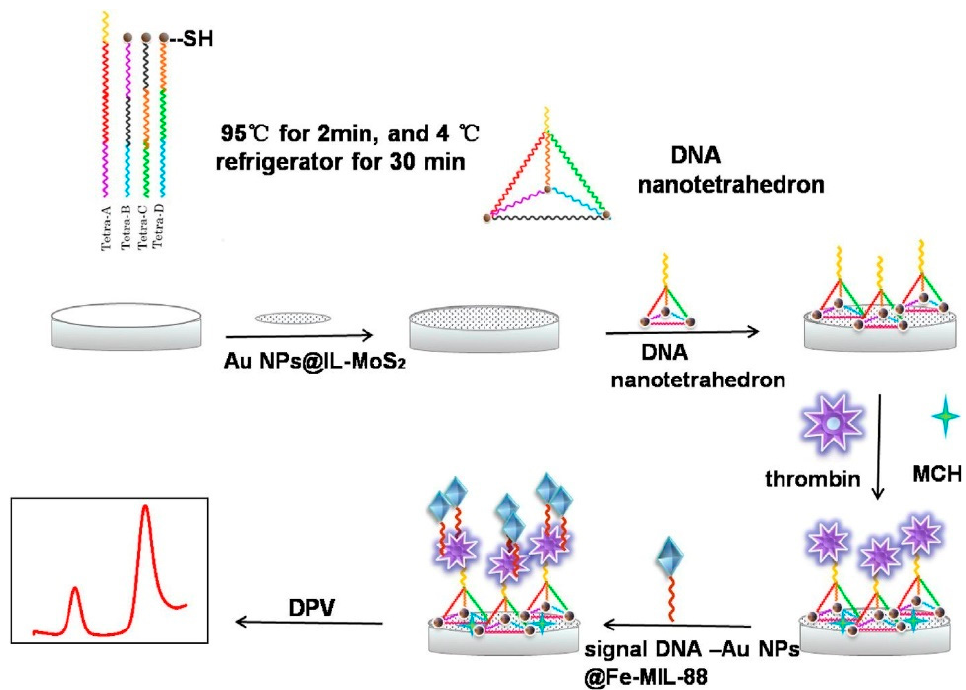
Figure 3. Electrochemical aptasensor for thrombin detection in blood serum. A glassy carbon elec- trode is coated with a AuNPs-IL-MoS 2 composite and functionalized with SH-DNA nonotetrahedrons that bind thrombin molecules and serve as supports for successive binding of AuNPs-Fe-MIL-88 MOFs. Image adapted from [28] with permission of Elsevier, 2020.